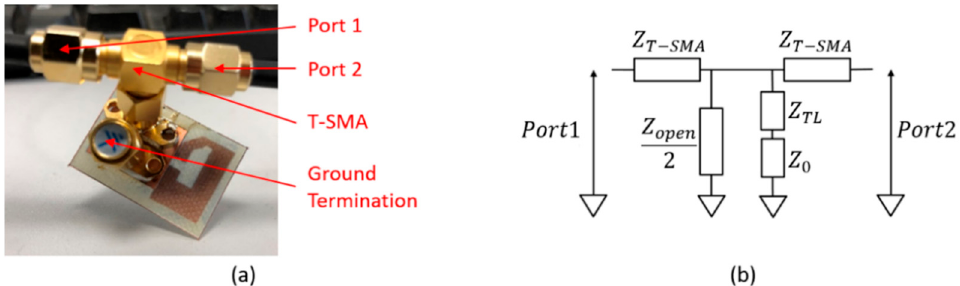
Figure 8. Shunt ‐ Thru characterization: ( a ) measurement setup; ( b ) equivalent circuit. The impedance 𝑍 (cid:3042)(cid:3043)(cid:3032)(cid:3041) can be determined by a first measurement without connecting the ground termination shown in Figure 8a.